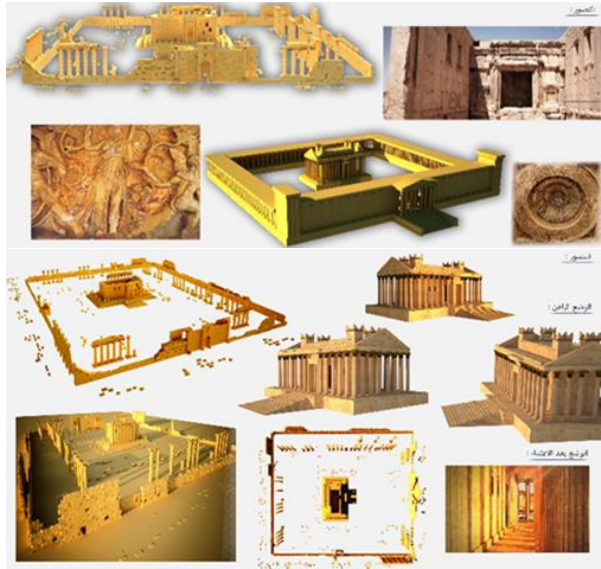
Figure (7) Ba’al Temple 3D modelling